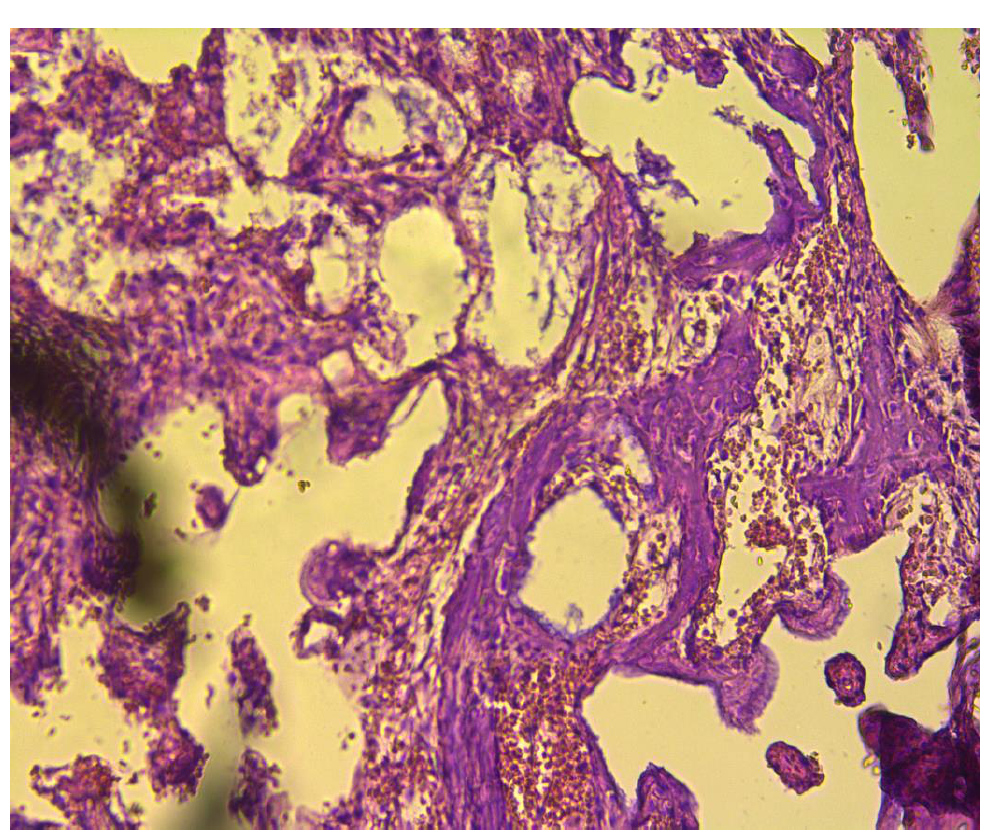
Figure (7 ):The blood clot in group 1 after 2